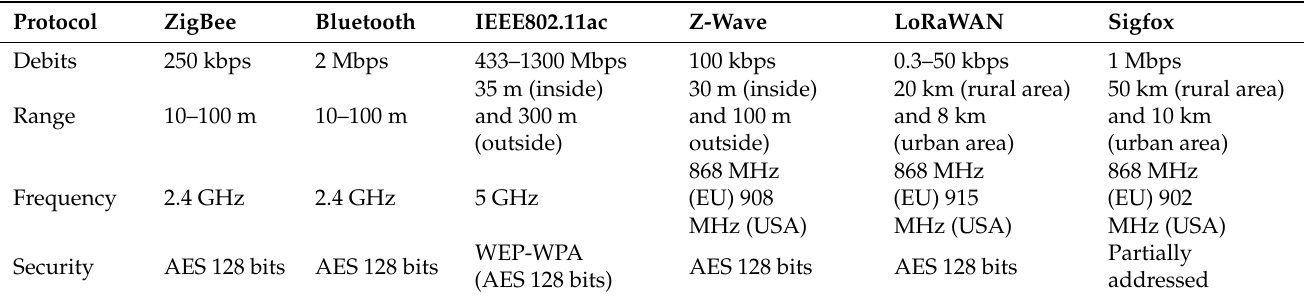
Table 1. Differences between different communication protocols in